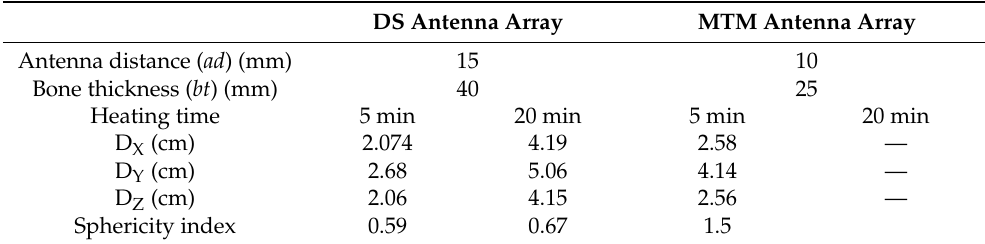
Table 8. Best-case scenarios of ablation zone dimensions for 5 min and 20 min (12 W) for the square configurations of DS and MTM